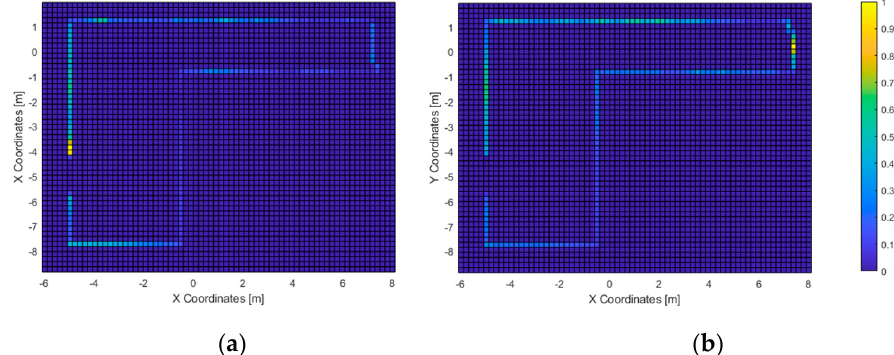
Figure 14. Test 2—Acoustic heatmaps of those who passed the test ( a ) and those who did not ( b ).